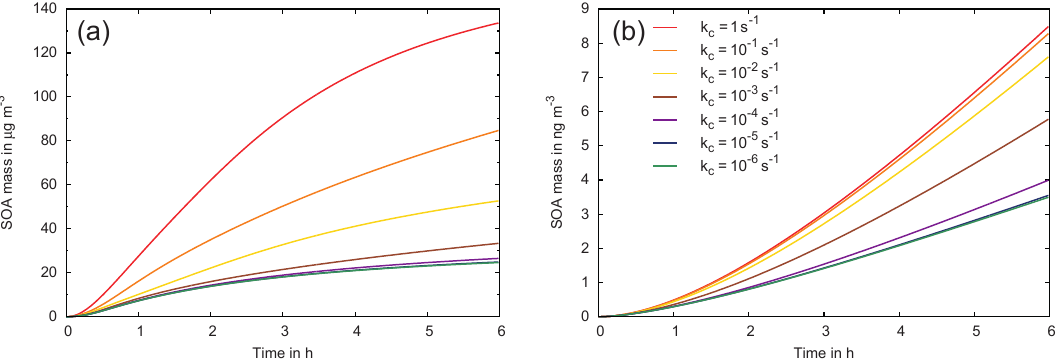
Figure 2. Simulated SOA mass for different pseudo-first-order rate constants of particle reactions k c (model case 2 of Table 1) using particle- phase bulk particle diffusion coefficients for (a) liquid ( D b = 10 − 12 m 2 s − 1 ) and (b) semi-solid ( D b = 10 − 18 m 2 s − 1 ) aerosol